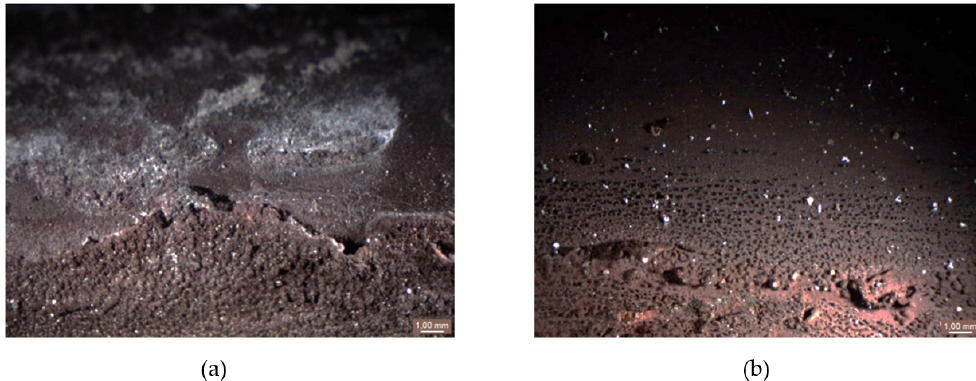
Figure 9. ( a ) The overall view of the inner surface of the tube bottom part from Figure 8. This is cutout 4 with a perforation of a large extent, according to Figure 2; ( b ) the corrosion layer on the interface of the condensed water vapor level.